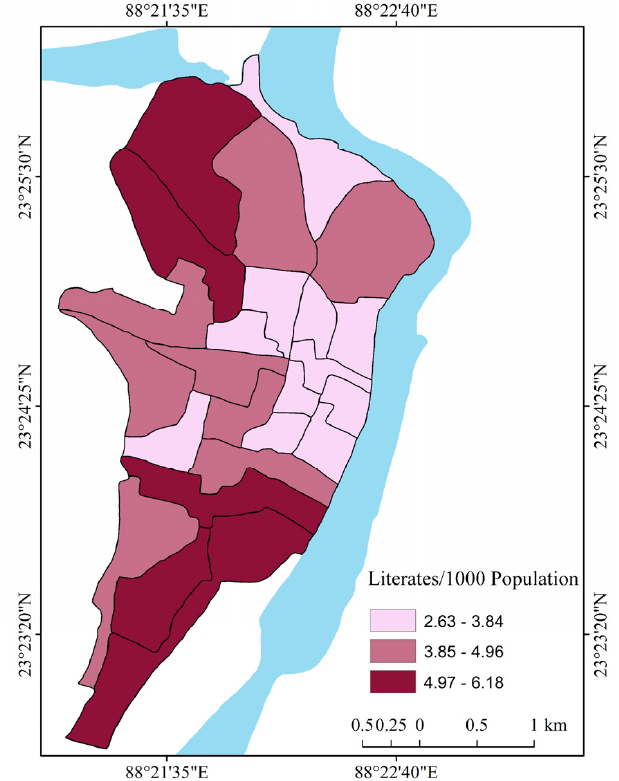
Figure 58. Ward-wise distribution of literates/1000 population in Nabadwip Municipality Figure 58. Ward ‐ wise distribution of literates/1000 population in Nabadwip Municipality (2011).